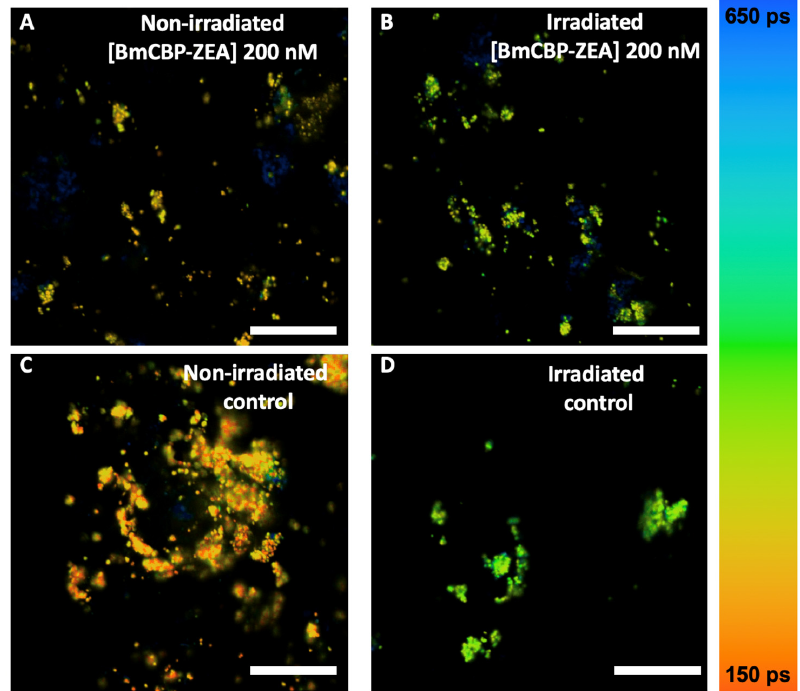
Figure 5. Effect of BmCBP-ZEA on the lifetime of fluorescence of lipofuscin granules, phagocytized by ARPE-19 cells, after irradiation by white light for 18 h. FLIM parameters: excitation λ exc: 473 nm; detection λ det: 530(40) nm; color scale encodes the range of lifetimes from 150 ps (orange) to 650 ps (blue). ( A , B ) Prior to the irradiation, cells were supplemented with media containing 200 nM BmCBP- ZEA. ( C , D ) Cell samples without BmCBP-ZEA (control). Measurements were performed immediately after irradiation finished. The measuring bar corresponds to 10 µ m.